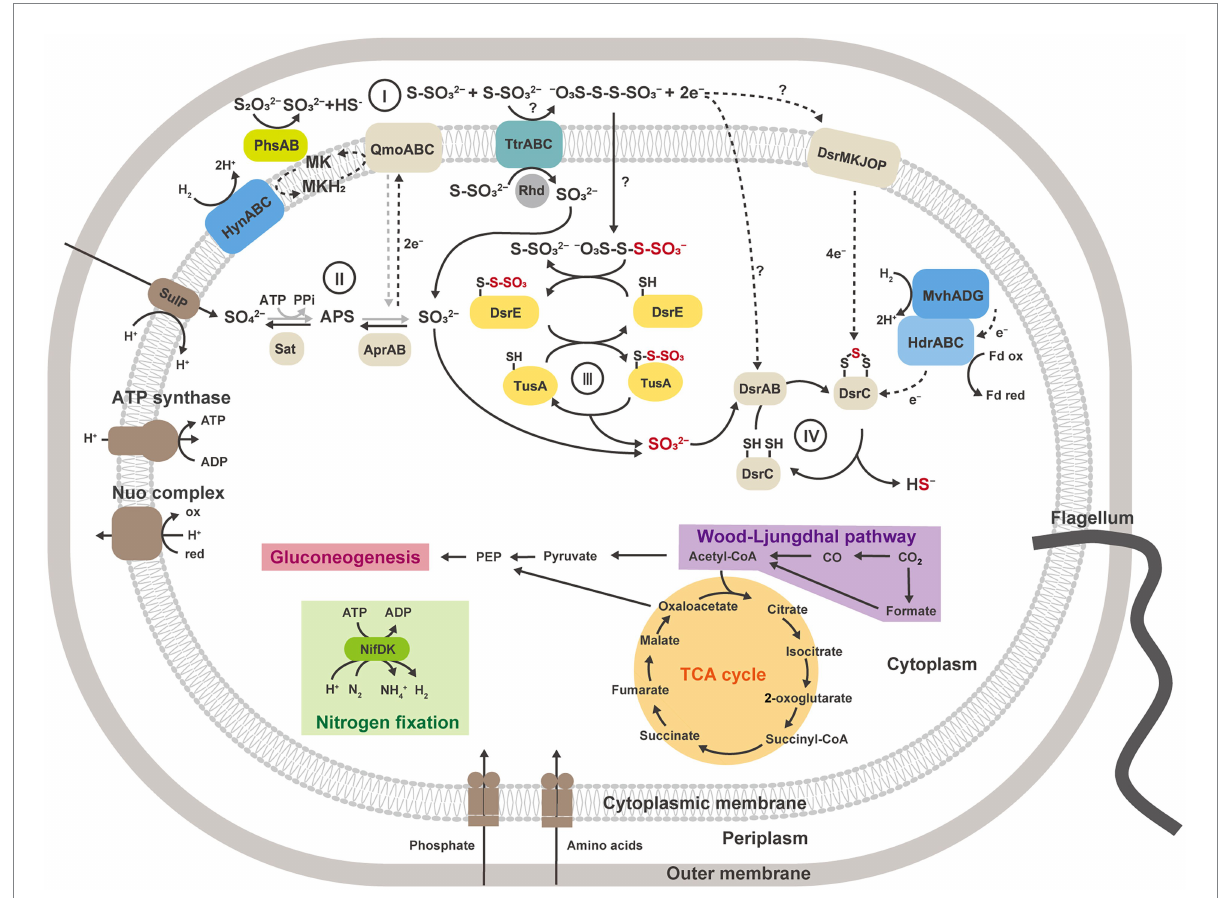
FIGURE 6 Metabolic reconstruction of strain GF1 T and proposed model for thiosulfate disproportionation in strain GF1 T , involving the enzyme reaction by tetrathionate reductase-type protein (I), oxidation of sulfite to sulfate by Apr and Sat (II), possible transfer of thiosulfonate derived from tetrathionate by potential sulfur carrier proteins and delivery of sulfite to DsrAB (III), reduction of sulfite to sulfide by DsrAB (IV). The strain grows via sulfur disproportionation and respiratory hydrogen oxidation coupled to sulfate reduction in the presence of CO 2 . When reactions can work in both directions, the pathway for dissimilatory sulfate reduction is shown in gray. Sat, sulfate-adenylyltransferase; Apr, adenylyl-sulfate reductase; APS, adenosine 5 ′ -phosphosulfate; Dsr, dissimilatory sulfite reductase subunit; Phs, thiosulfate reductase-type protein; Ttr, tetrathionate reductase-type protein; Rhd, rhodanese-like domain-containing protein; Qmo, APS reductase-associated electron transfer